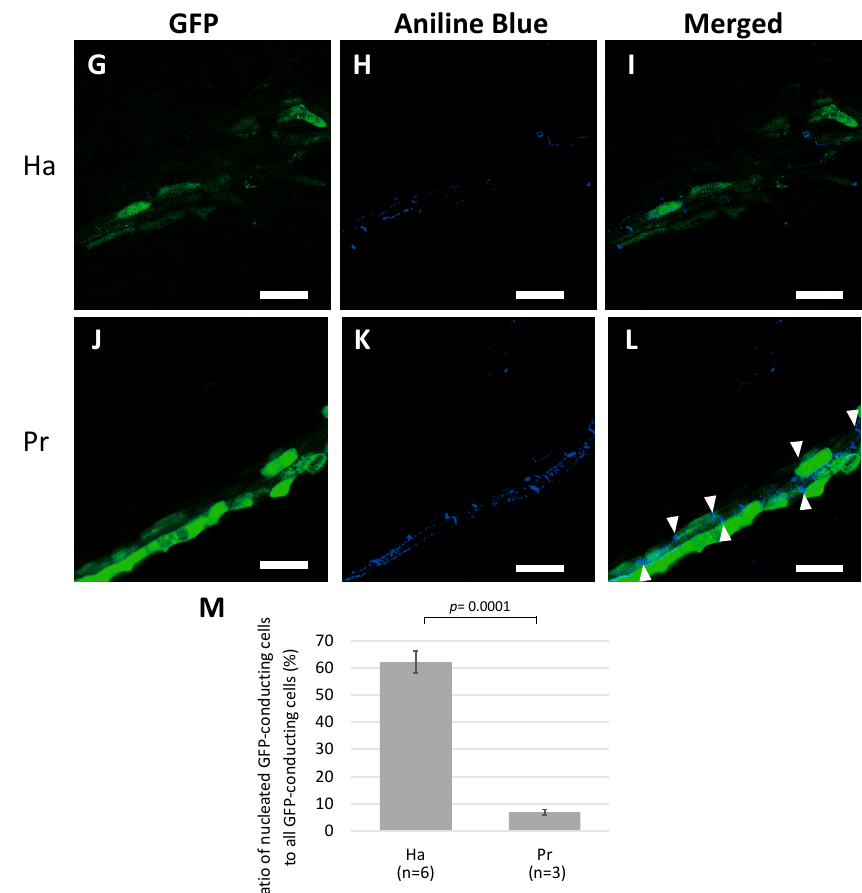
Figure 4. Detection of nuclei and callose-rich sieve plates in green fluorescent protein (GFP)-conducting cells in a 1-cm-diameter tubercle. ( A – C ) 4 ′ 6-diamidino-2-phenylindole (DAPI) staining of haustorial cells; ( A ) GFP, ( B ) DAPI, and ( C ) merged. ( D – F ) DAPI staining of protrusion cells; ( D ) GFP, ( E ) DAPI, and ( F ) merged. White arrows indicate nuclei. ( G – I ) Aniline Blue staining of haustorial cells; ( G ) GFP, ( H ) Aniline Blue, and ( I ) merged. ( J – L ) Aniline Blue staining of protrusion cells; ( J ) GFP, ( H ) Aniline Blue, and ( I ) merged. White triangles indicate sieve plates. Scale bar: 50 μ m. ( M ) Percentage of nucleated GFP-conducting cells to all GFP-conducting cells. Ha, haustorium; Pr, protrusion. The means and standard deviations of six and three different haustorial and protrusion specimens, respectively, are presented. n : number of specimens.